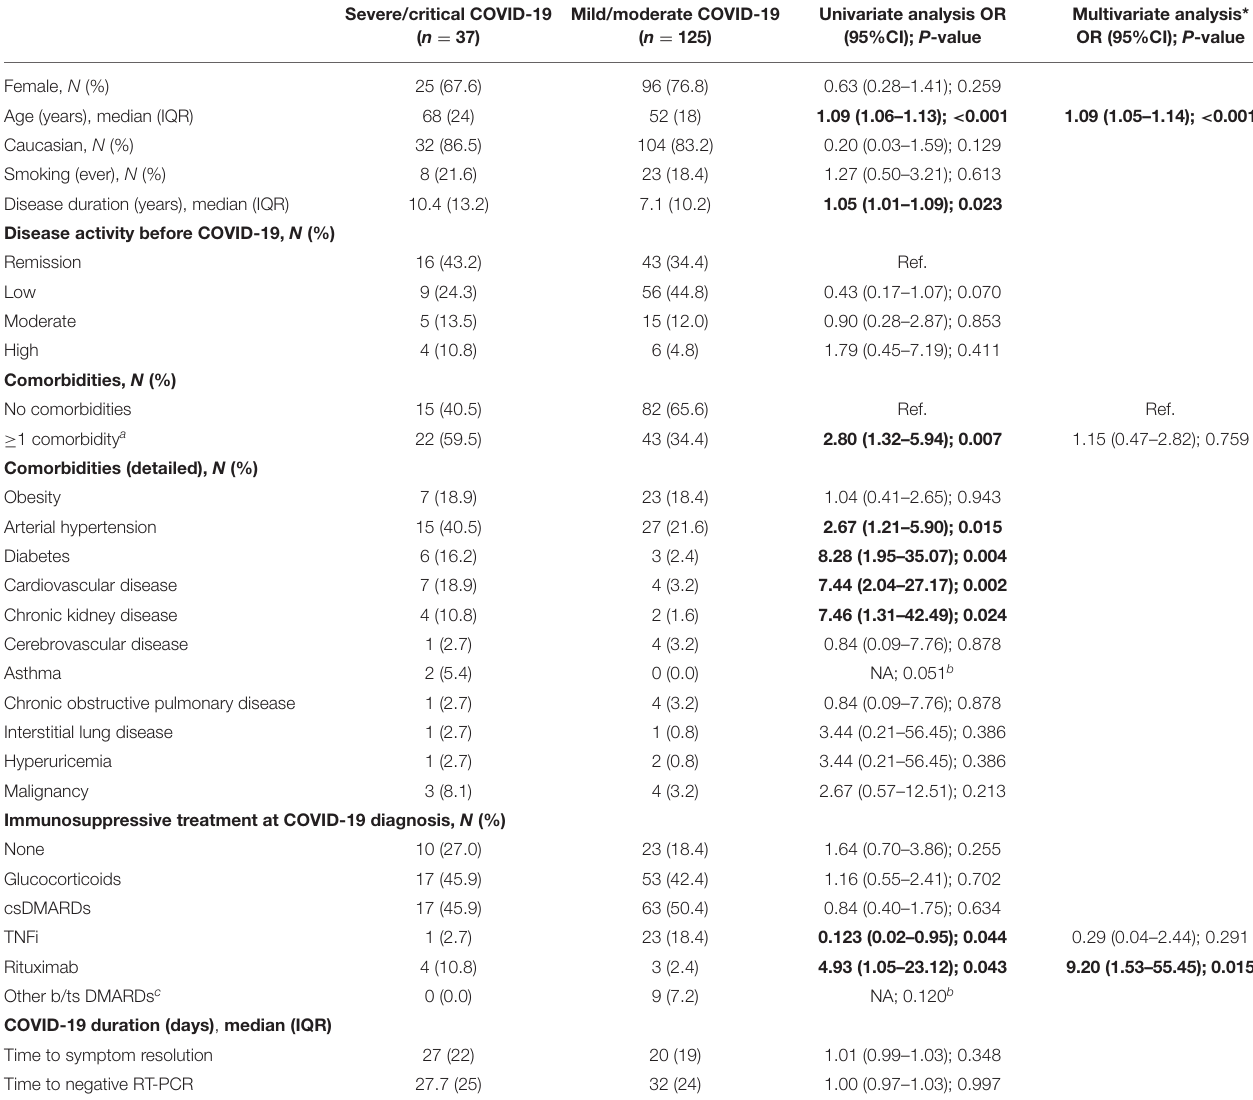
TABLE 4 | Comparison of COVID-19 + patients with severe/critical course and mild/moderate disease.